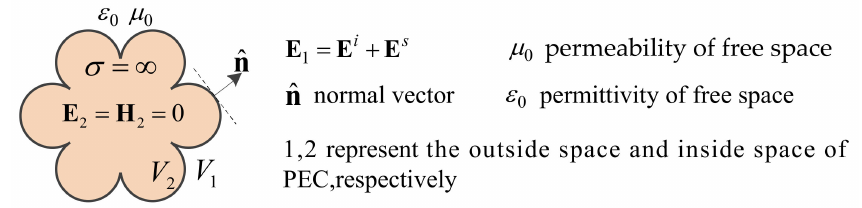
Figure 1. Electric field boundary conditions of the power lines as the